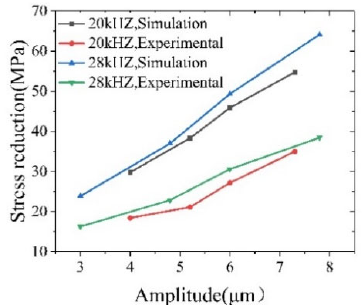
Figure 19. The effect of the tensile rate on the magnitude of the stress reduction. Figure 18. A comparison of the experimental and simulated values of the stress reduction.